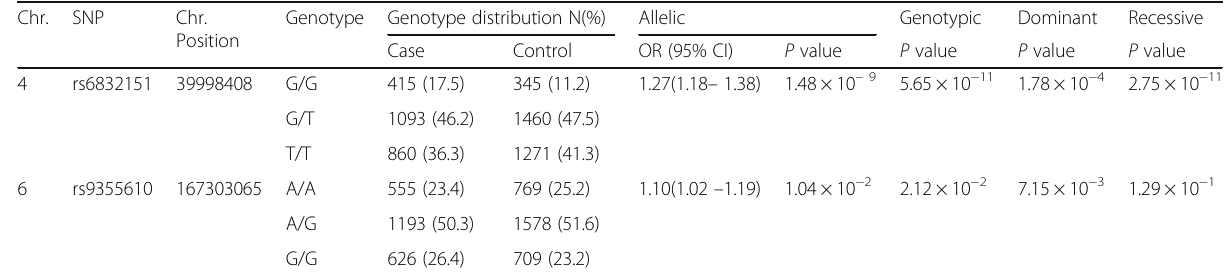
Table 2 Case – control association analysis of the two SNPs Chr. SNP